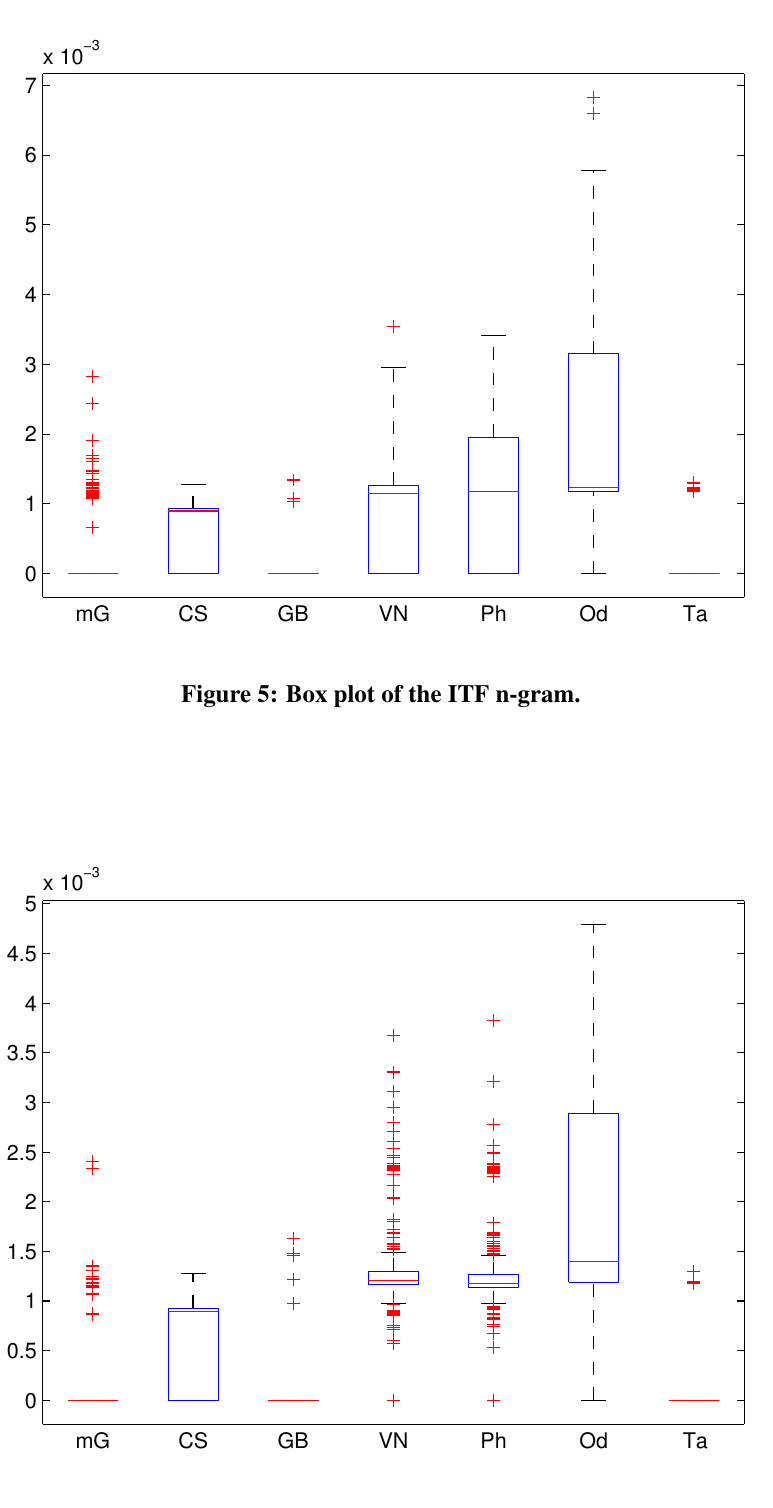
Figure 6: Box plot of the FSM